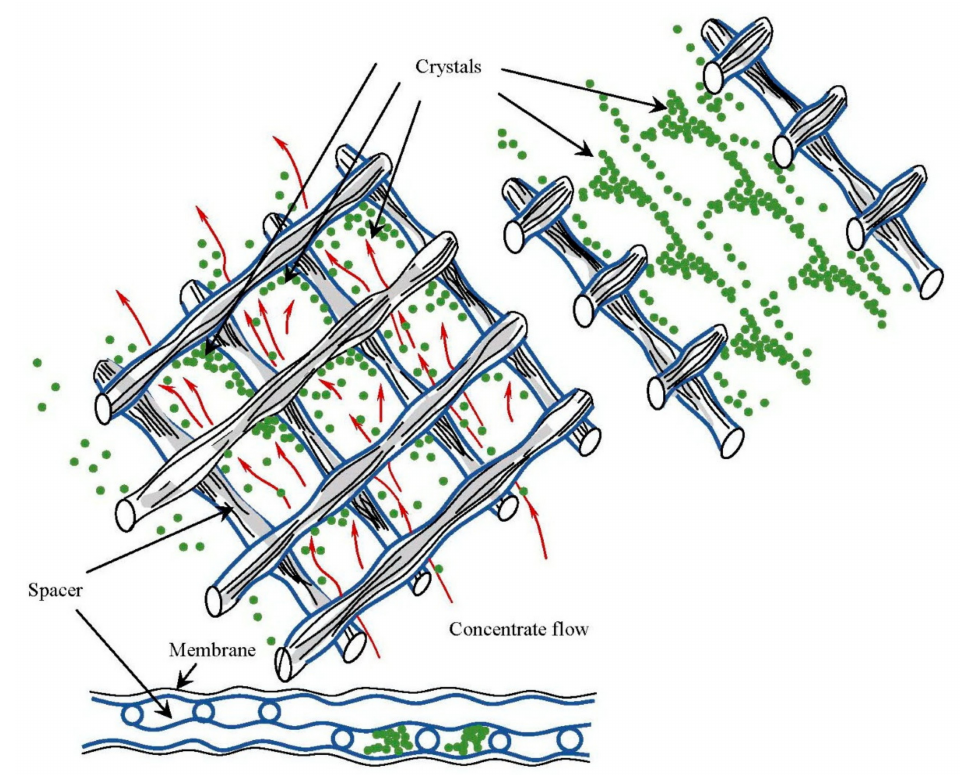
Figure 2. Formation of “dead area” in the places where the mesh touches the membrane